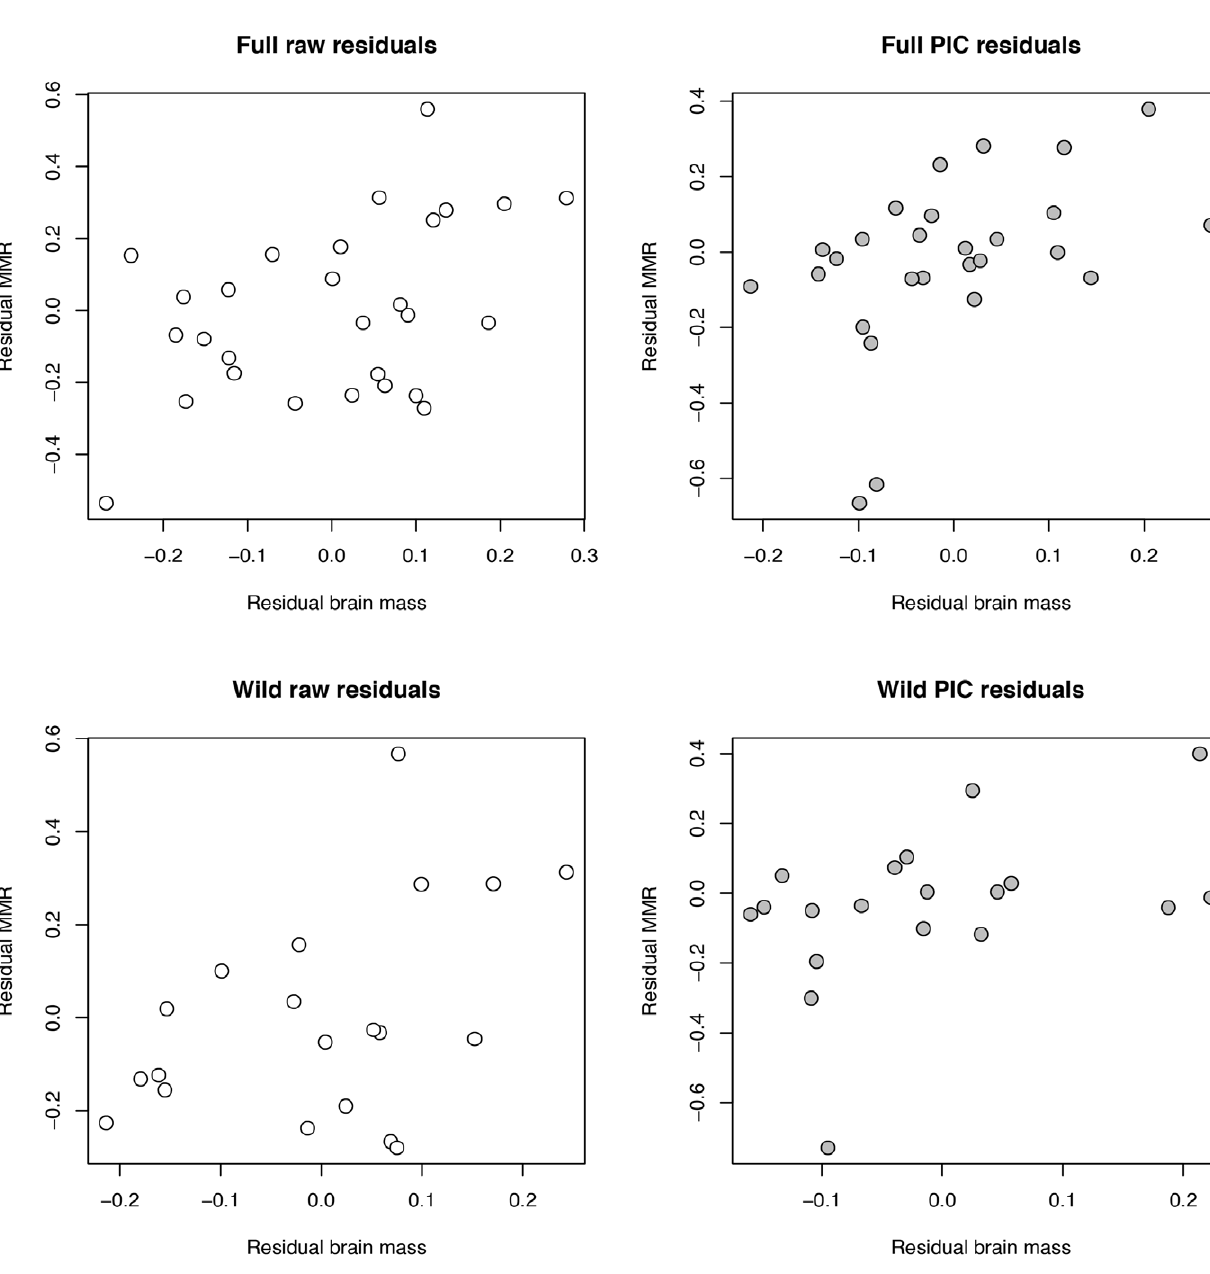
Figure 3. Relationship between raw and independent contrasts of residuals of brain mass from body mass and residuals of MMR from body mass in the full sample (A and B respectively) and the wild-only sample (C and D